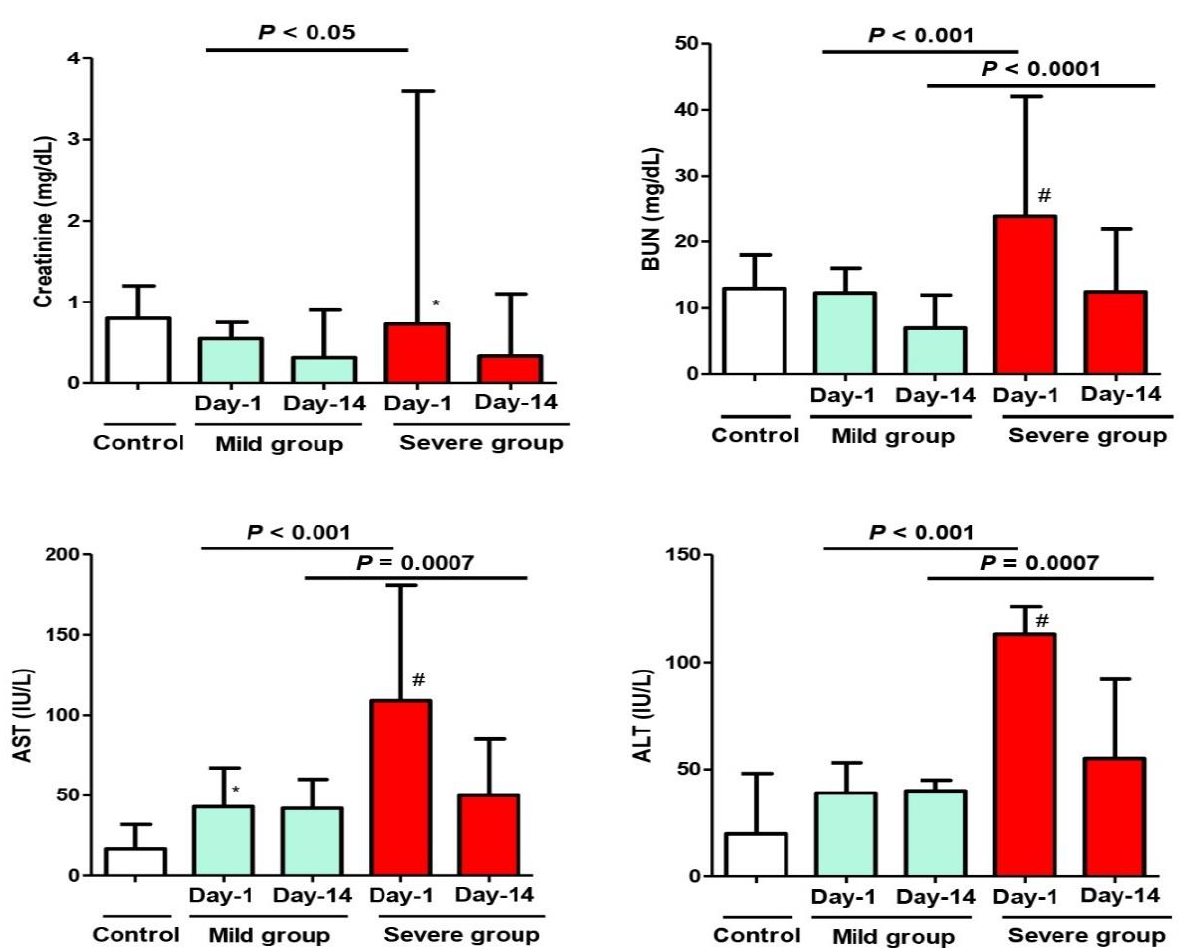
Figure 3. Changes in the biochemical parameters (Creatinine, BUN, AST, ALT) of the study cohort on Day 1 and Day 14 after admission with MIS-C manifestations. Control Group = Simple COVID-19 infection; Group A = Mild MIS-C; Group B = Severe MIS-C. BUN: Blood Urea Nitrogen; ALT: alanine aminotransferase; AST: aspartate aminotransferase. * p < 0.05 and # p < 0.01, statistically significant difference compared to the control group (one-way ANOVA followed by Tukey’s post -test).